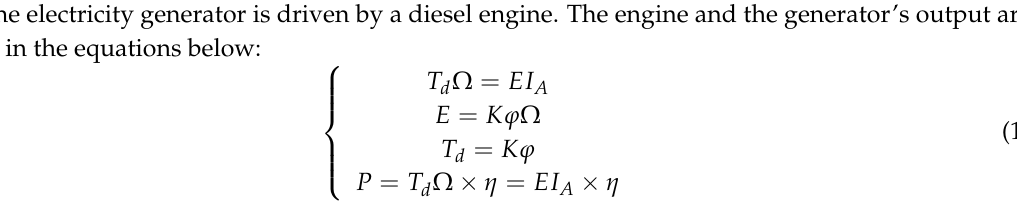
Figure 3. The computational model of the DG-ES system configuration.